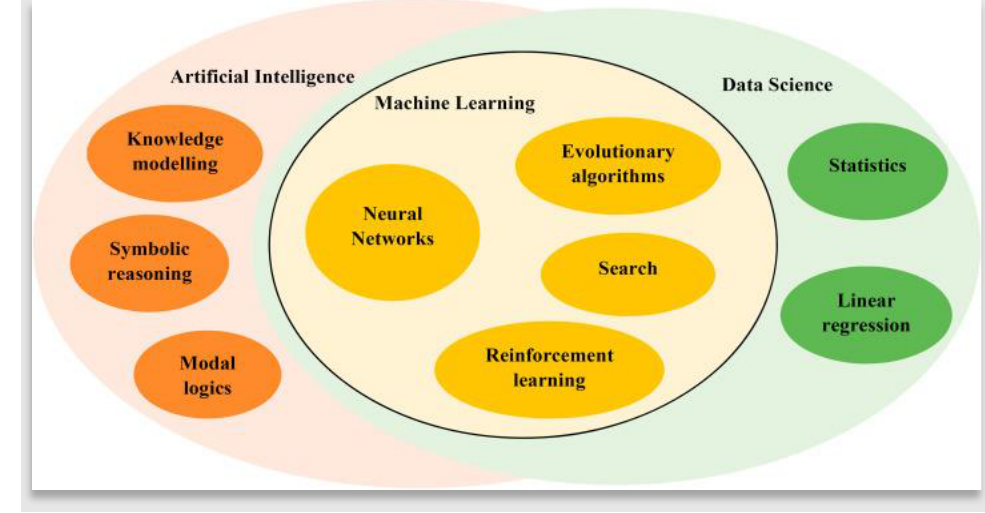
Figure 1. T he correlation among the expanded AI, ML, and DL